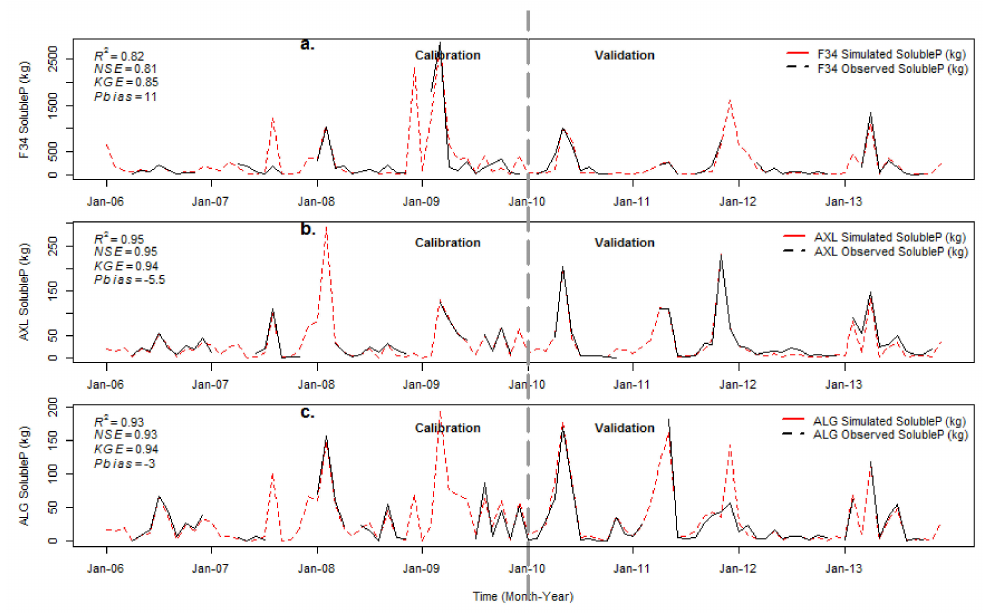
Figure A3. Monthly time series of simulated and observed soluble P for ( a ) F34, ( b ) AXL, and ( c ) ALG. There were no measured soluble P data available for CCW to perform calibration and